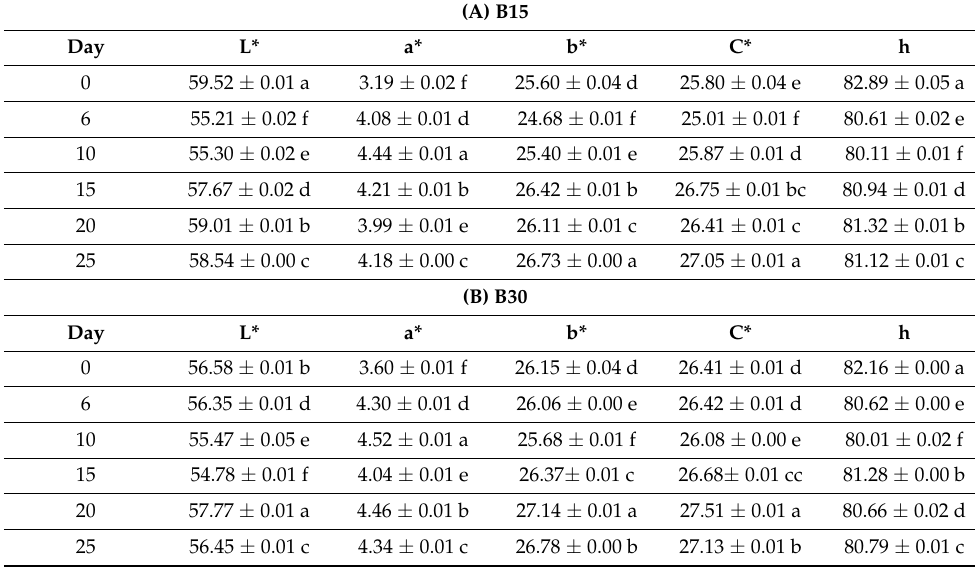
Table 1. Changes in the colorimetric profile of cottonseed butters over the accelerated oxidation storage at 60 ◦ C. B15 and B30, butter products made from the cottonseed roasted at 150 ◦ C for 15 and 30 min, respectively. Data are present in the format of average ± standard deviation (n = 3). Different letters in the same column indicate these values are statistically significantly different ( p ≤